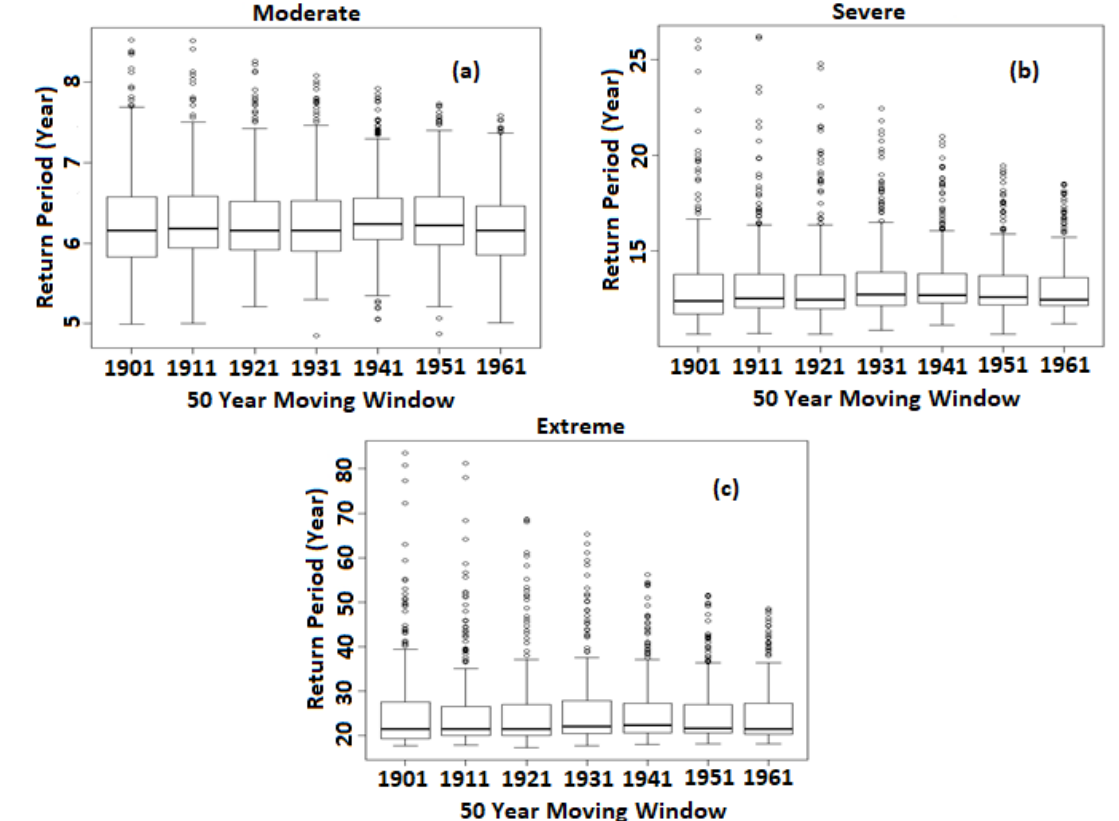
Figure 12. The box-plots showing the return periods of ( a ) moderate, ( b ) severe, and ( c ) extreme corn droughts estimated for different 50-year windows over the period 1901–2010.